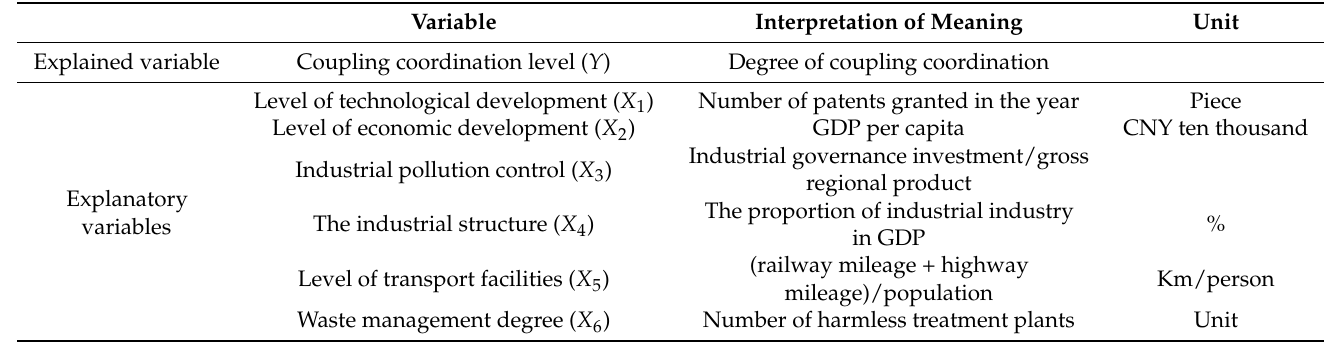
Table 7. Influencing factors and variable explanations of regional logistics and ecological environment development